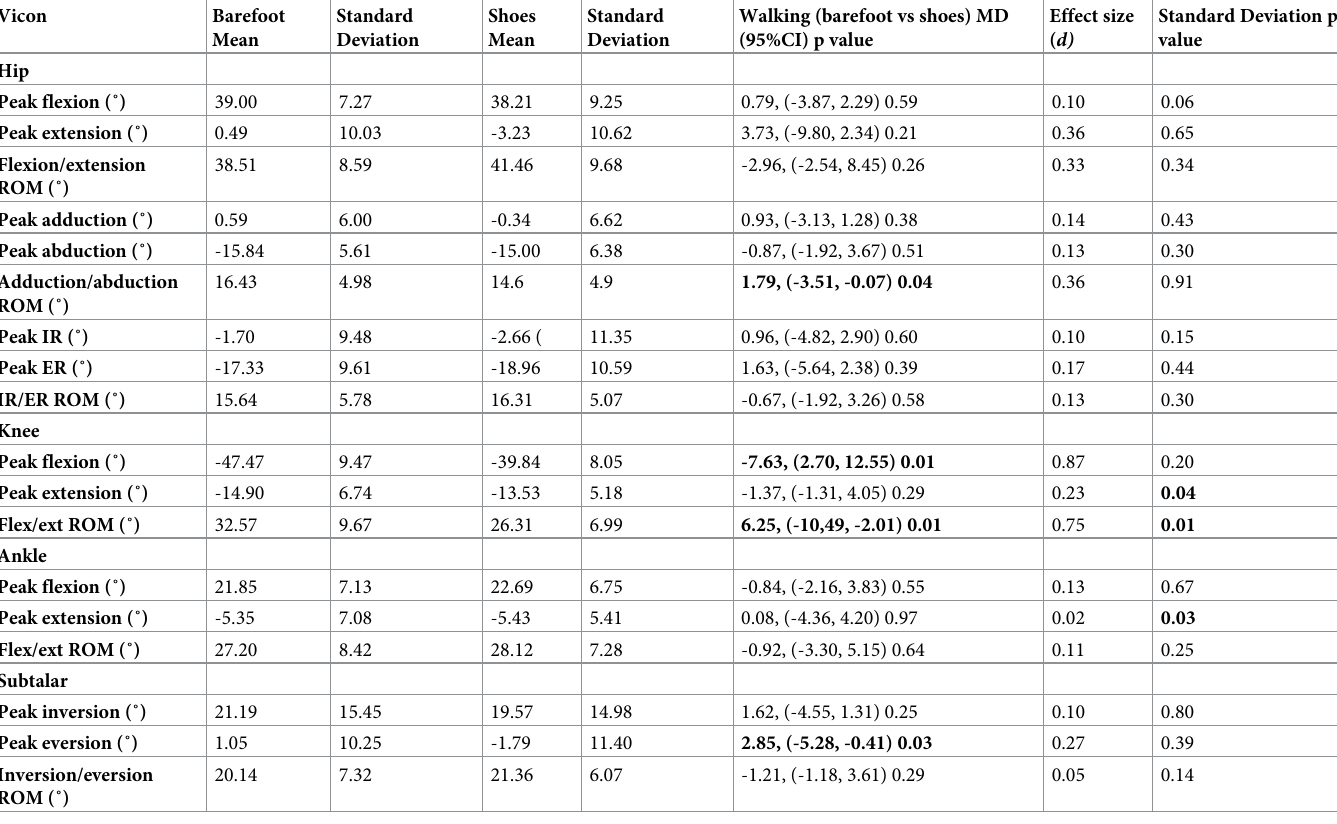
Table 2. Kinematic variables for barefoot and footwear conditions (right side only). Vicon Barefoot